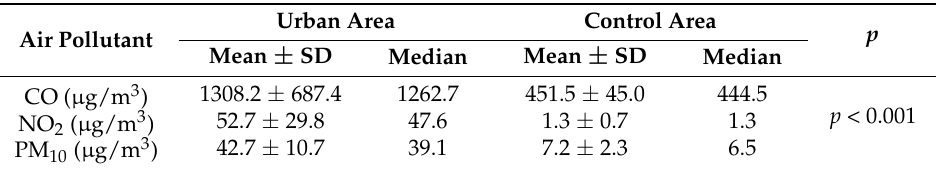
Table 1. Basic statistics of concentrations of selected air pollutants measured in urban and control areas during short